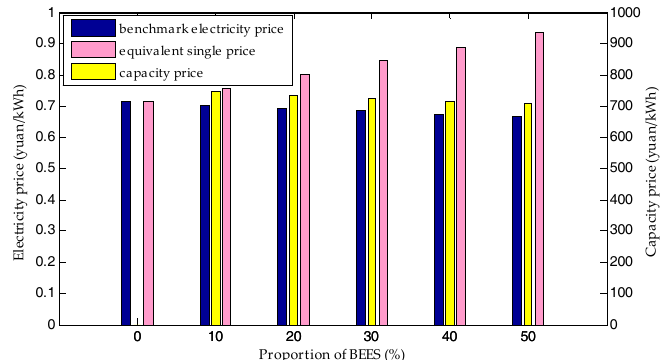
Figure 10. Comparison of the electricity price of the 50 MW PV plant with different proportions of BESS.